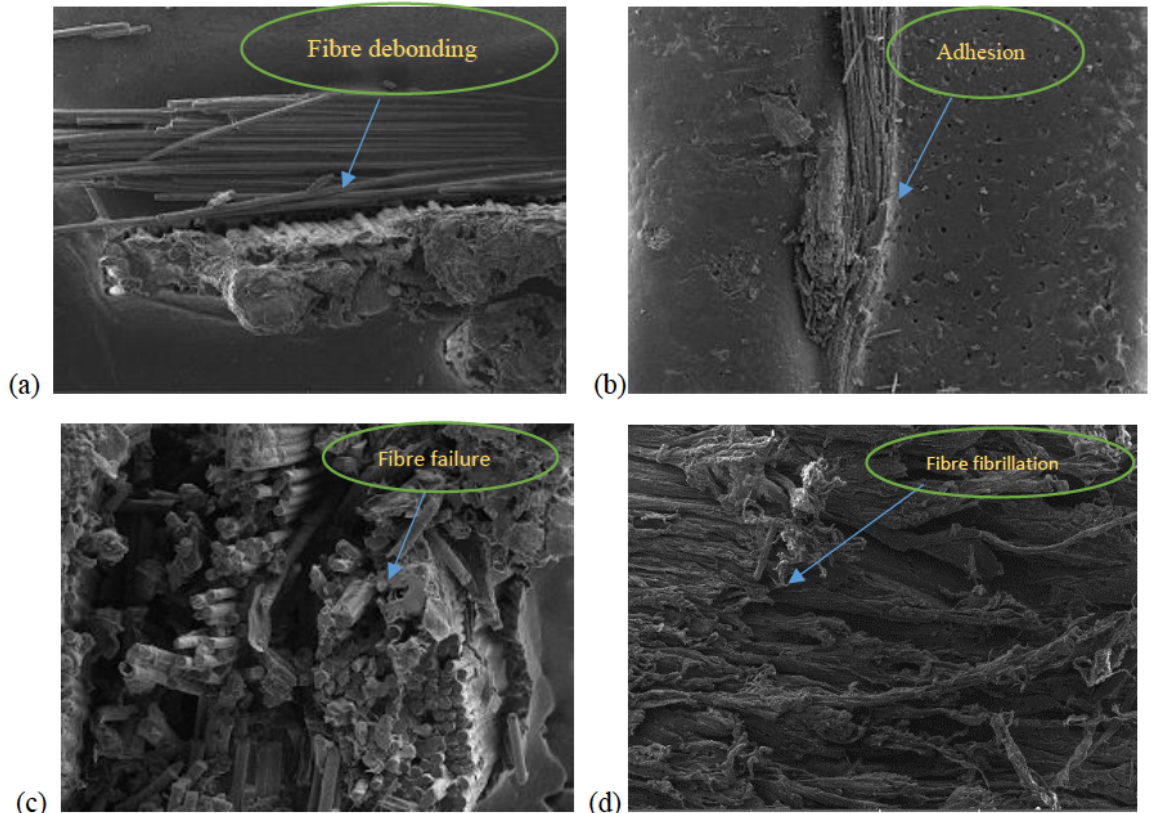
Figure 9: FESEM images of PP (a)Conventional sample (b)laser sample at 100X Magnification (c)laser sample at 500X Magnification factor (d) AWJ